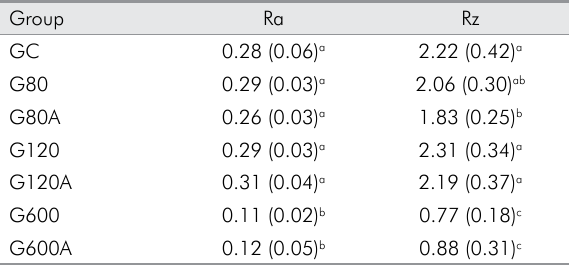
Table 2. Surface roughness values of the test groups (mean and standard deviation, in µm).